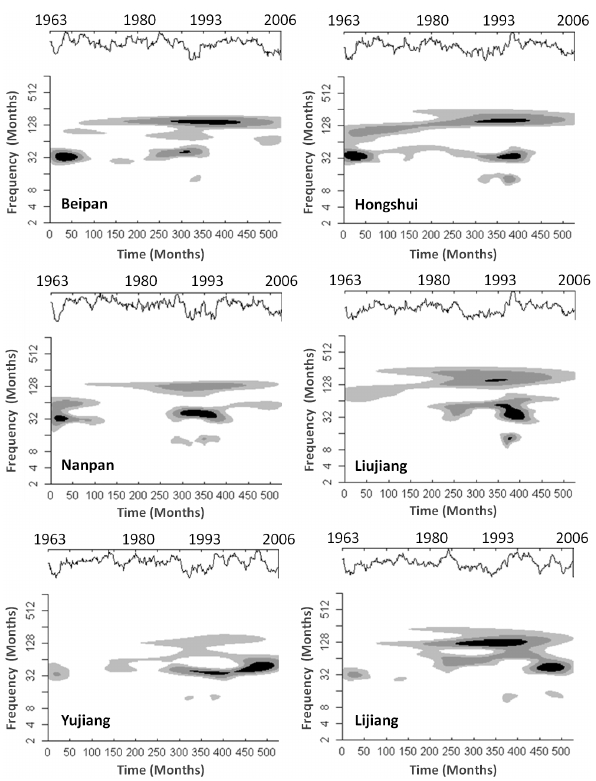
Fig. 12. Wavelet analysis of the SPI-24 of the six sub-basins in the Xijiang River basin showing the low (grey) to high (black) signifi- cant amplitudes of the frequencies.